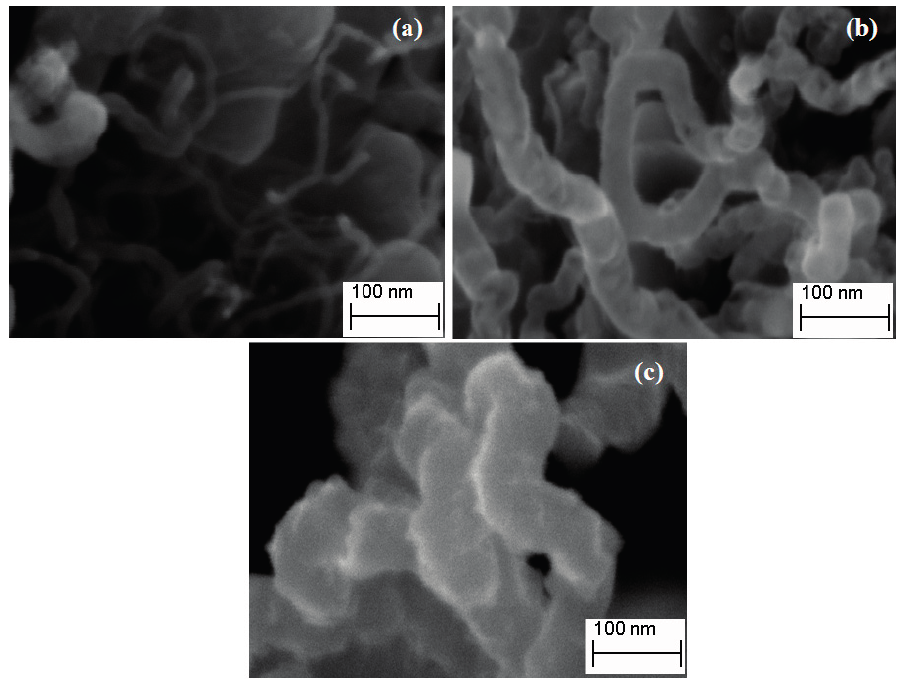
Figure 5. Field Emission Scanning Electron Microscope (FESEM) micrograph of CoNiAl-CNT ( a ); FeNiAl-CNT ( b ) and FeCoNiAl-CNT ( c ).